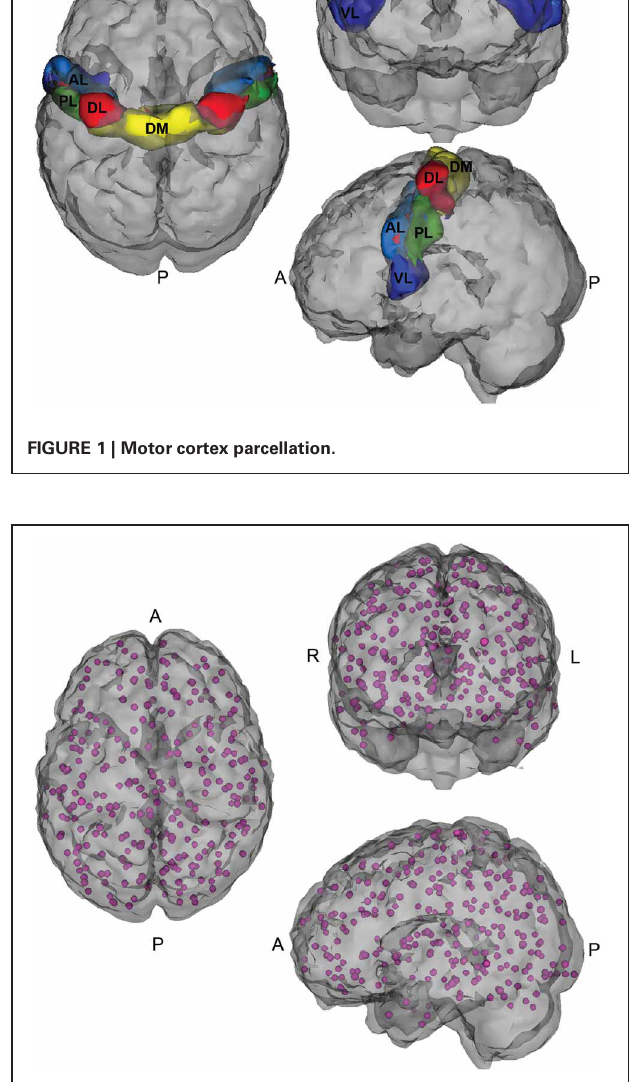
FIGURE 2 | 264 seed